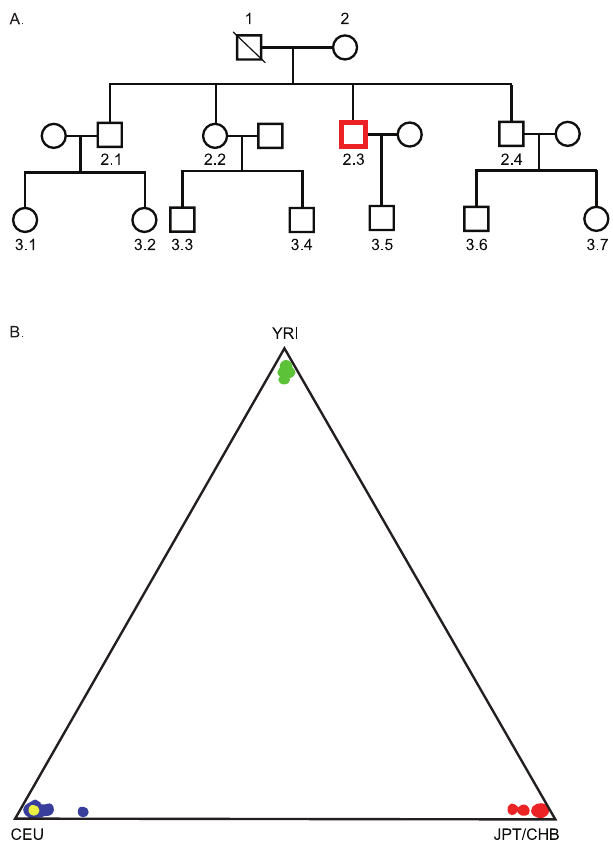
Figure 1. DNA Donor Pedigree and Relatedness to Ethnogeographic Populations (A) Three-generation pedigree showing the relation of ancestors to study DNA sample. The donor is identified in red. (B) Cluster analysis based on 750 SNP genotype information to infer the ancestry of the HuRef donor. The figure shows the proportion of membership of the HuRef donor (yellow) to three pre-defined HapMap populations (CEU ¼ Northern and Western Europe, YRI ¼ Yoruban, Ibadan, Nigeria, and JPT þ CHB ¼ Japanase, Tokyo, and Han Chinese, Beijing). The results indicate that the HuRef donor clusters with 99.5% similarity to the samples of northern and western European ancestry.